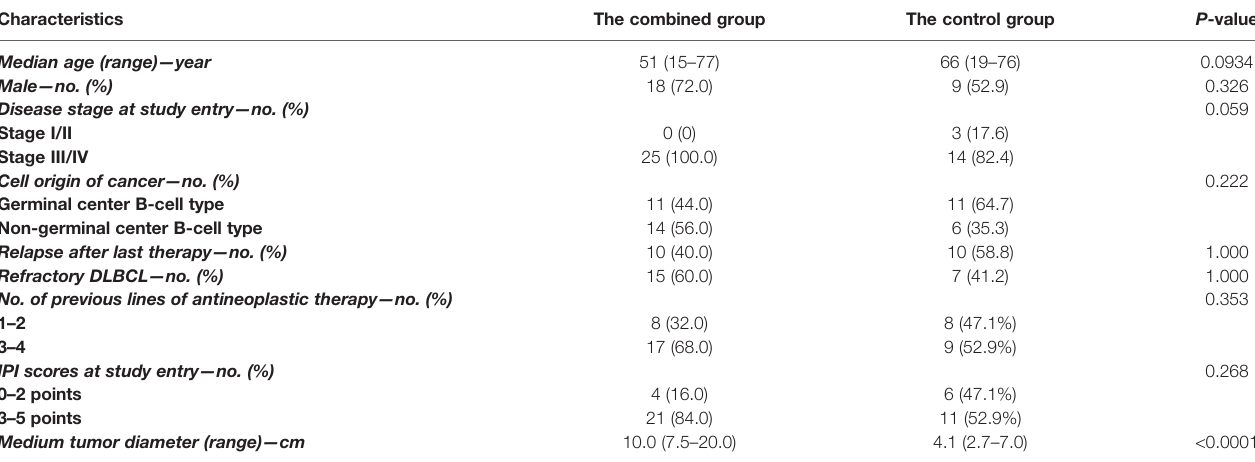
TABLE 2 | Comparison of baseline characteristics of patients between the combined and control groups. Characteristics The combined group The control